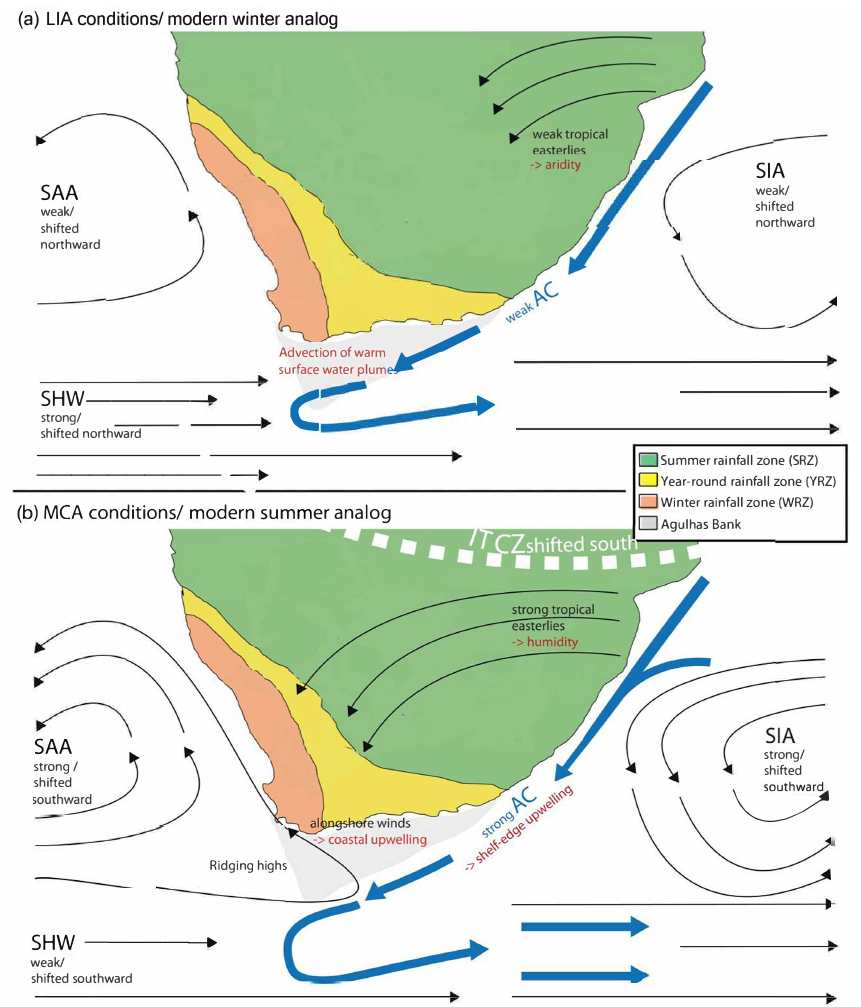
Figure 6. Conceptual model after Cohen and Tyson (1995) depicting the recorded response (in red) to shifts in atmospheric (indicated in black) and oceanic (in blue) circulation patterns during the LIA (a) and MCA (b) . Abbreviations: SIA (South Indian anticyclone), SAA (South Atlantic anticyclone), SHW (southern hemispheric westerlies), AC (Agulhas Current), LIA (Little Ice Age), MCA (Medieval Climate Anomaly), and ITCZ (Intertropical Convergence